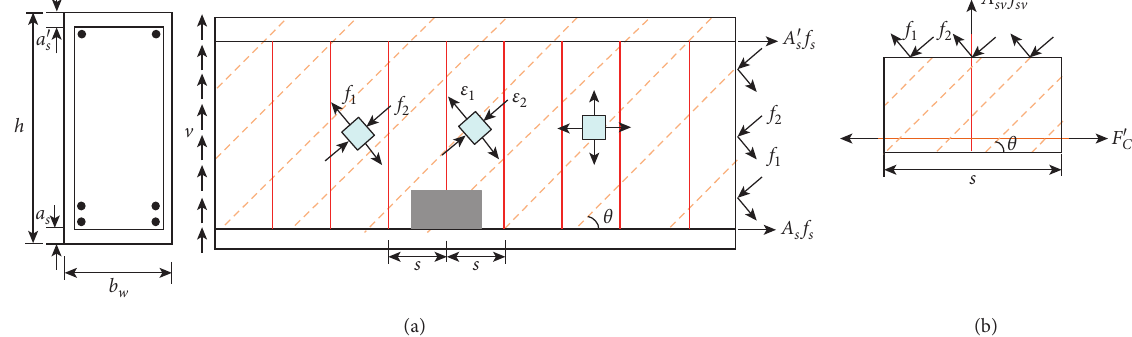
Figure 3: Analysis model of a UHPC beam based on MCFT. (a) Principal stress of UHPC; (b) equilibrium of UHPC element forces.